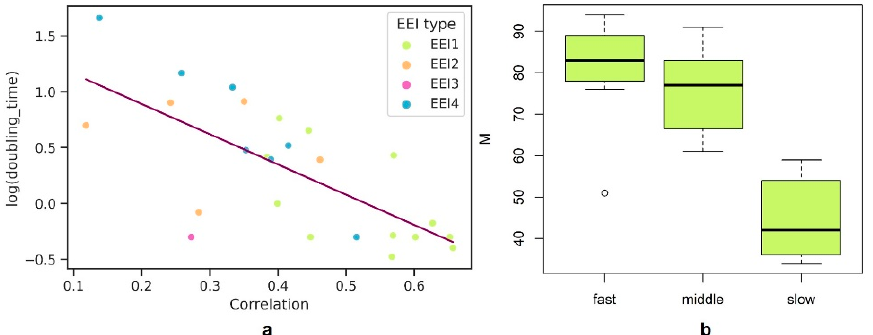
Figure 5. ( a ) Dependence of corr(PA|EEI) coefficient from the logarithm of minimal doubling time for 25 organisms. The color describes EEI type (see the legend). The trend line is colored purple; ( b ) distribution of bacteria with diverse growth rates (with the minimal doubling time <2 h, ≥ 2 h and <5 h, and ≥ 5 h for the fast, medium, and slow growing bacteria, respectively) by the M param- eter.